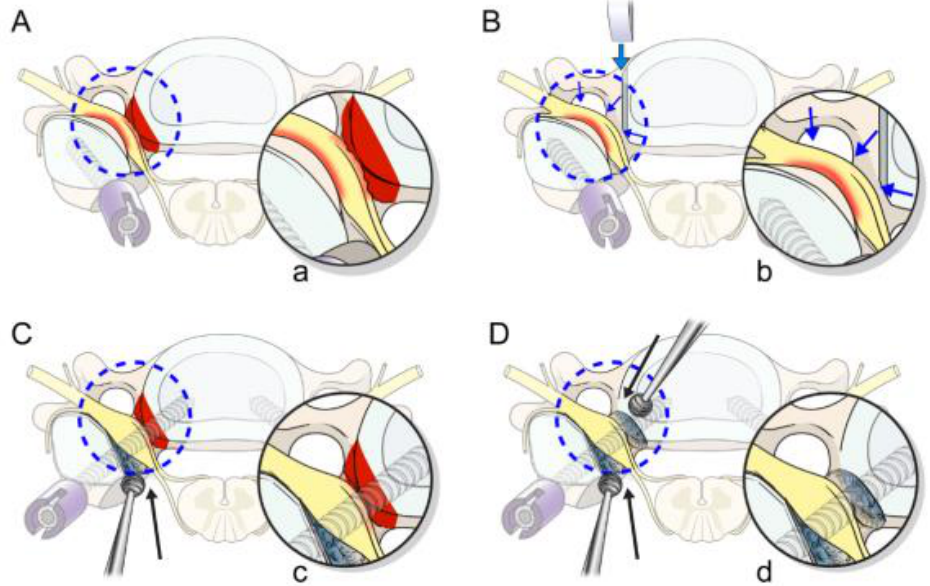
Figure 3. Illustration showing the effects of posterior decompression alone, compared with other techniques of foramen decompression. ( A ) Laminectomy alone with lateral mass screws shows tethering of the C5 root with sudden dural shift inside the narrow foramen. ( B ) Uncovertebrectomy with lateral mass screws. Although the effective decompression of the C5 root is achieved, this technique does not eliminate the possibility of C5 root impingement because the lateral mass is preserved for better screw purchase. ( C ) Posterior foraminotomy and laminectomy with pedicle screws. Posterior foraminotomy was carried out before laminectomy, which offers the least chance of the impingement of the C5 root after the dural posterior shift with laminectomy. However, the uncinate process still compresses the root, especially when foraminal stenosis has severely decreased foraminal height. ( D ) Adding the anterior decompression and insertion of allospacers to maximize the size of the foramen after posterior foraminotomy in the PAP pedicle group. PAP, posterior anterior – posterior.